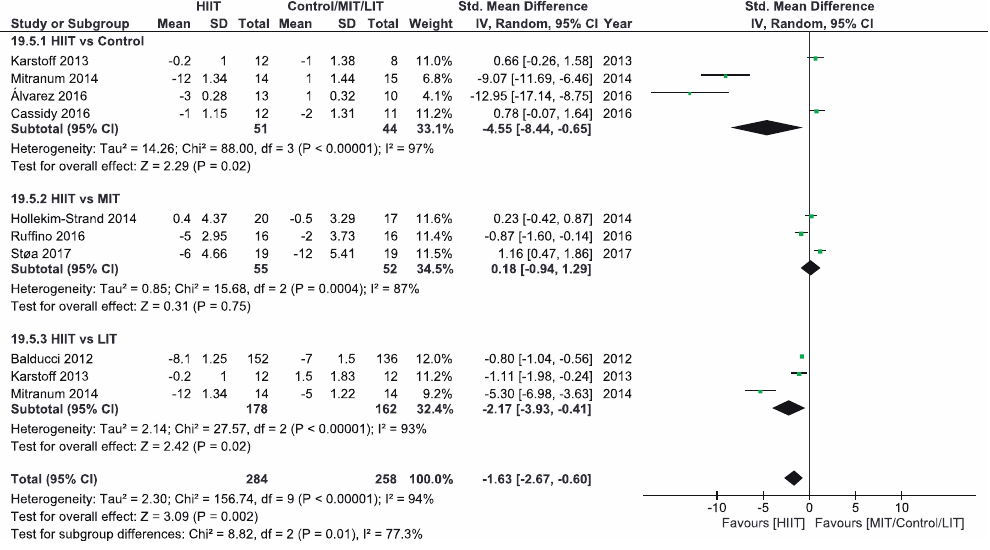
Figure 4. Forest plot for systolic BP. HIIT—high-intensity interval training, MIT—moderate-intensity training, LIT—low-intensity training, CI—confidence interval, IV—inverse variance, SD—standard deviation.